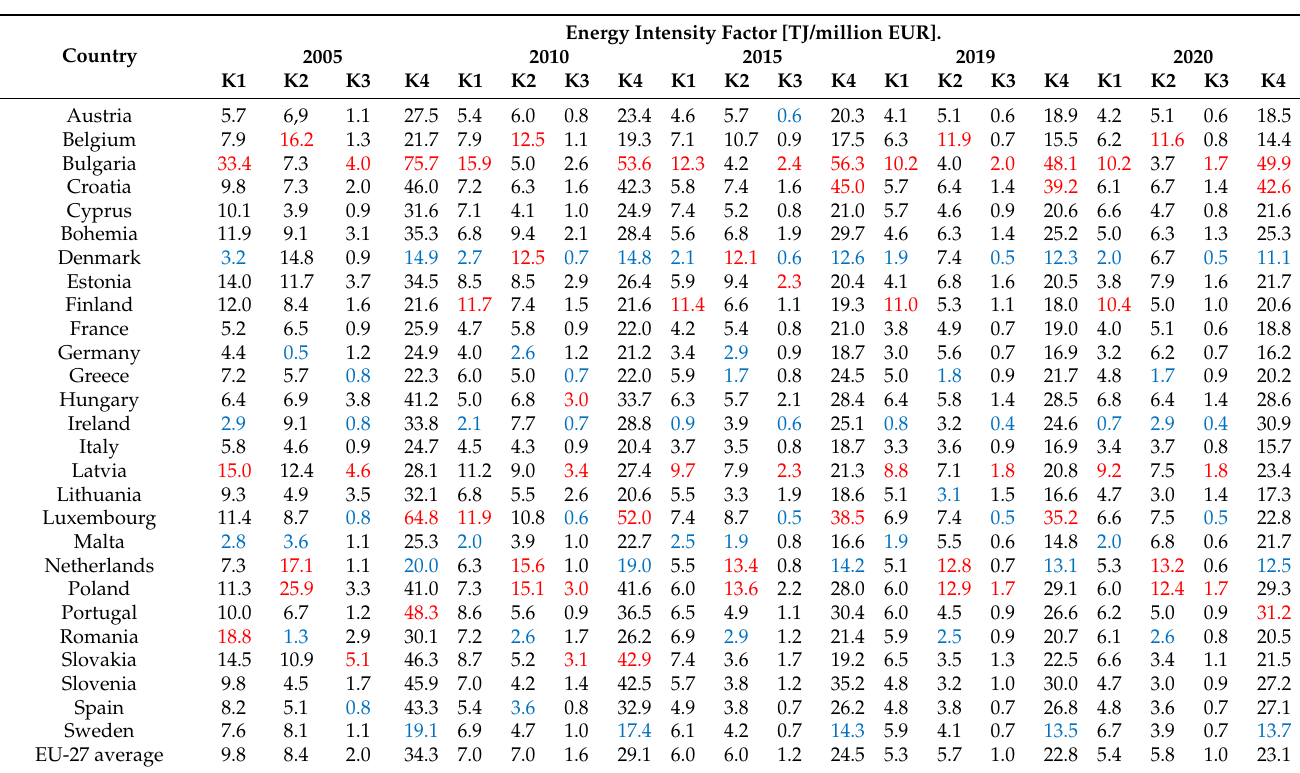
Table 5. Energy intensity factor values by sector in EU countries from 2005 to 2020. Blue indicates the three best performers in a given sector and period, and red the three worst